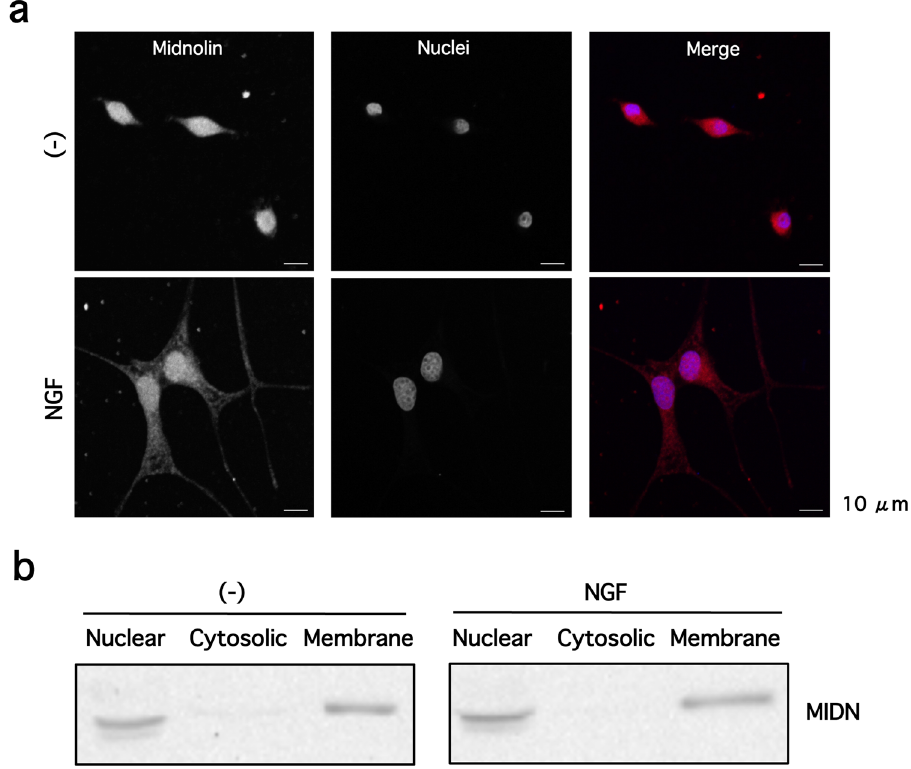
Figure 3. MIDN localizes primarily to the nucleus and intracellular membranes in PC12 cells. ( a ) PC12 cells were incubated in the presence or absence of 100 ng/ml NGF for one day before being stained with anti-MIDN antibody. Localization of endogenous MIDN was observed using a confocal laser scanning microscope. MIDN and nuclei were colored in red and blue, respectively in the merge image. Scale bar: 10 µ m (b) Following the NGF incubation described above, cells were homogenized and fractionated into nuclear, cytosolic, and crude membrane fractions as described in Methods. The MIDN in these fractions was then examined by Western blotting.